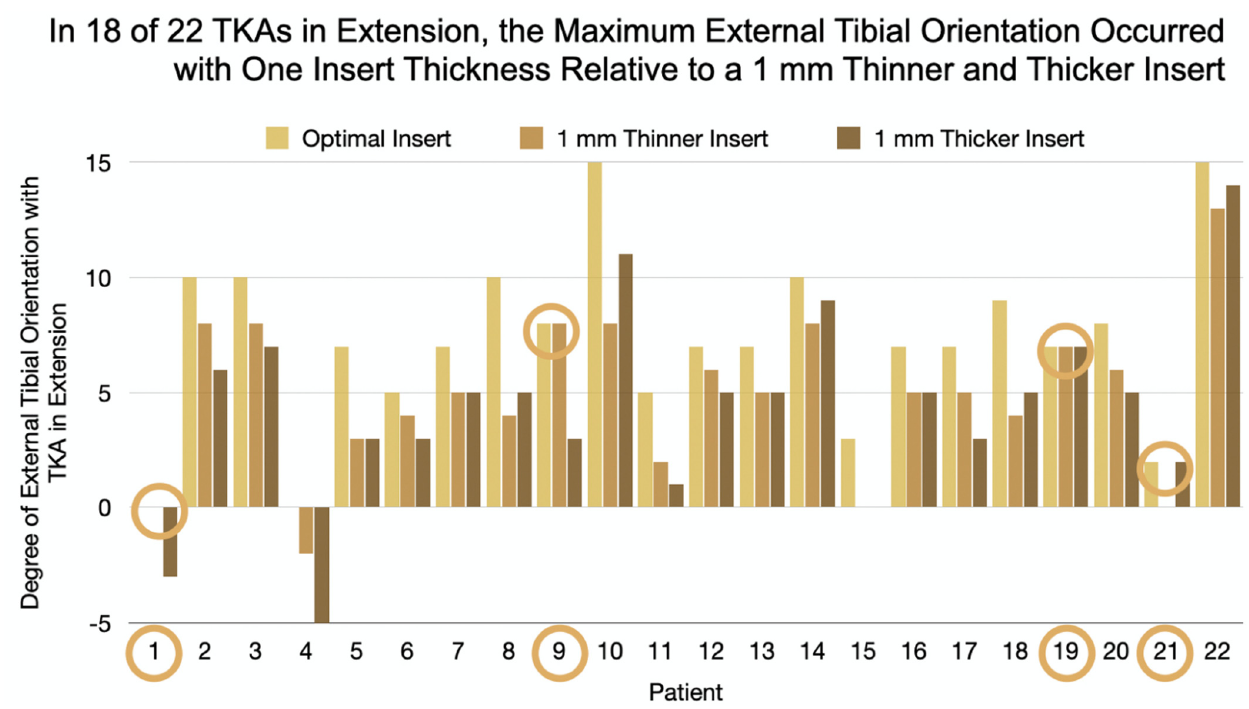
Figure 3. For each TKA in extension, the column graph shows the degree of external tibial orientation for the optimal and 1 mm thinner and thicker inserts. The optimal insert thickness was determined at 90° flexion in four patients because two insert thicknesses had the same maximum external orientation in extension (circled in brown).